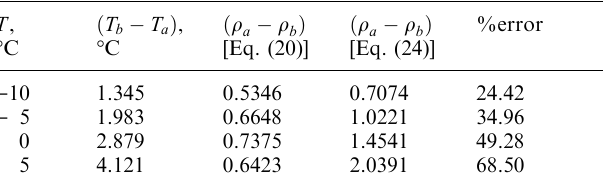
Table 2 Saturated water vapour density di(cid:128)erence as a function of